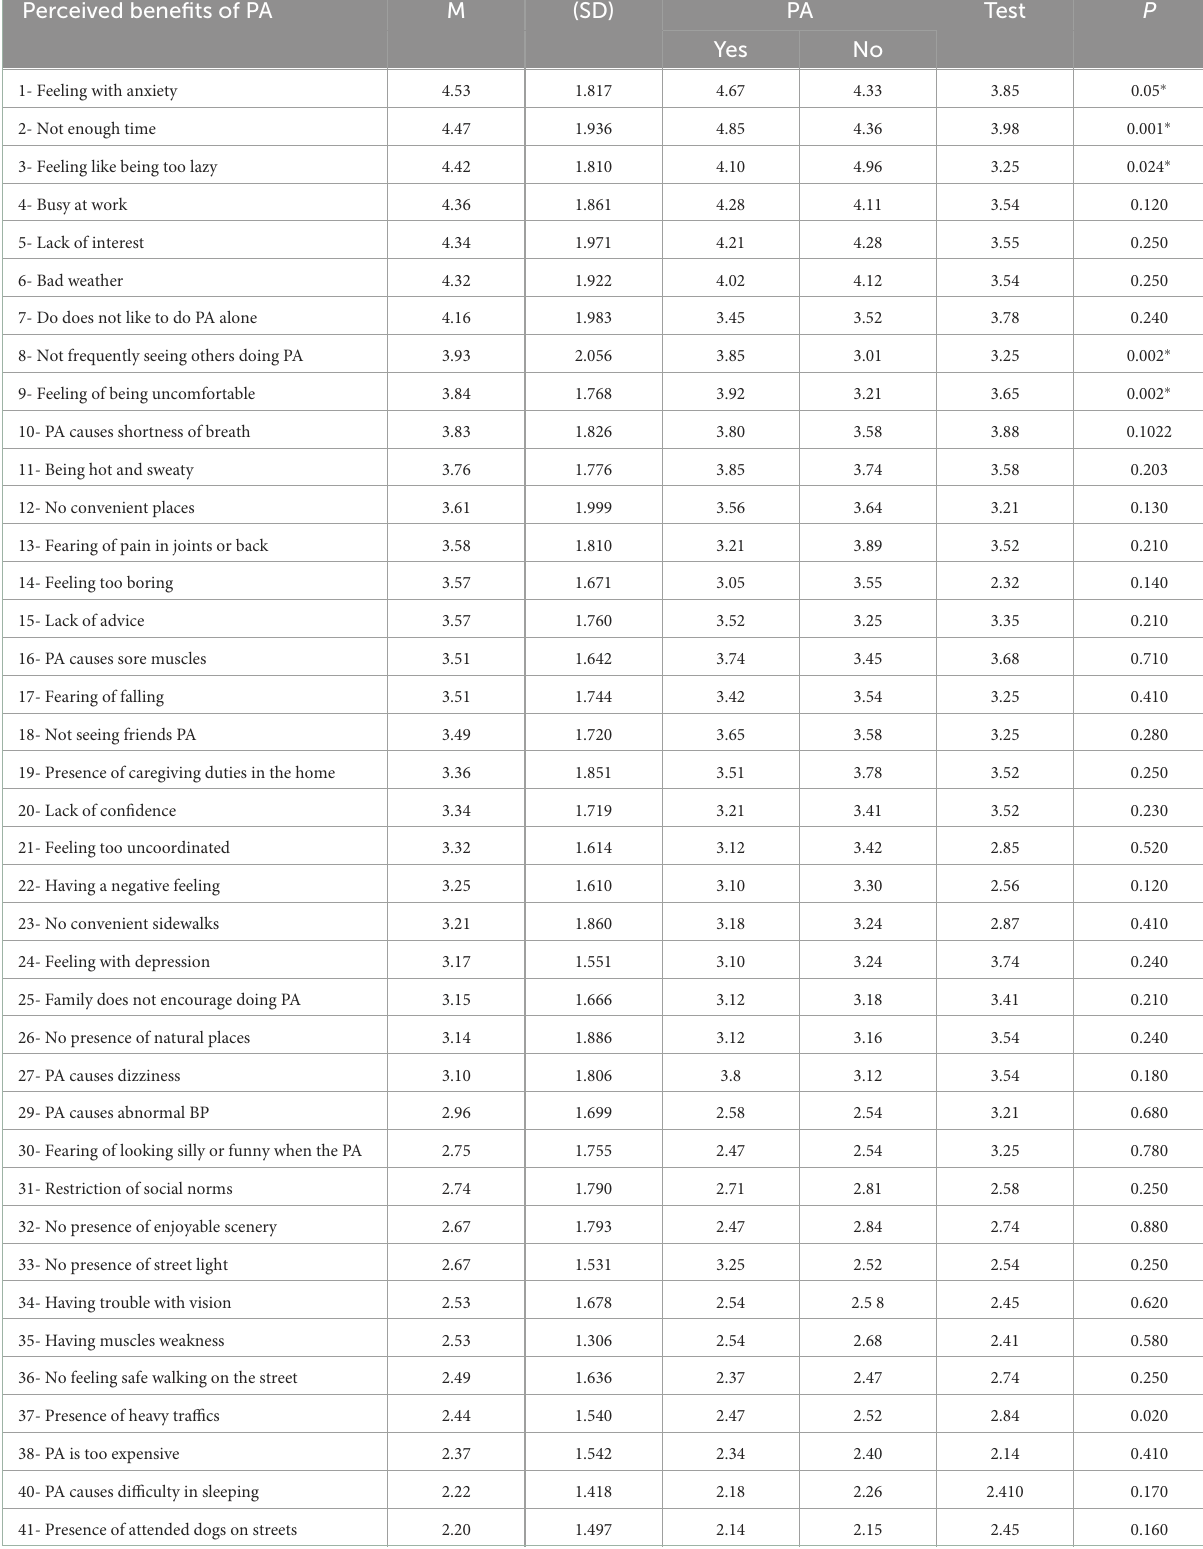
TABLE 6 Barriers to physical activity as perceived by Jordanian patients with CHD. Perceived benefits of